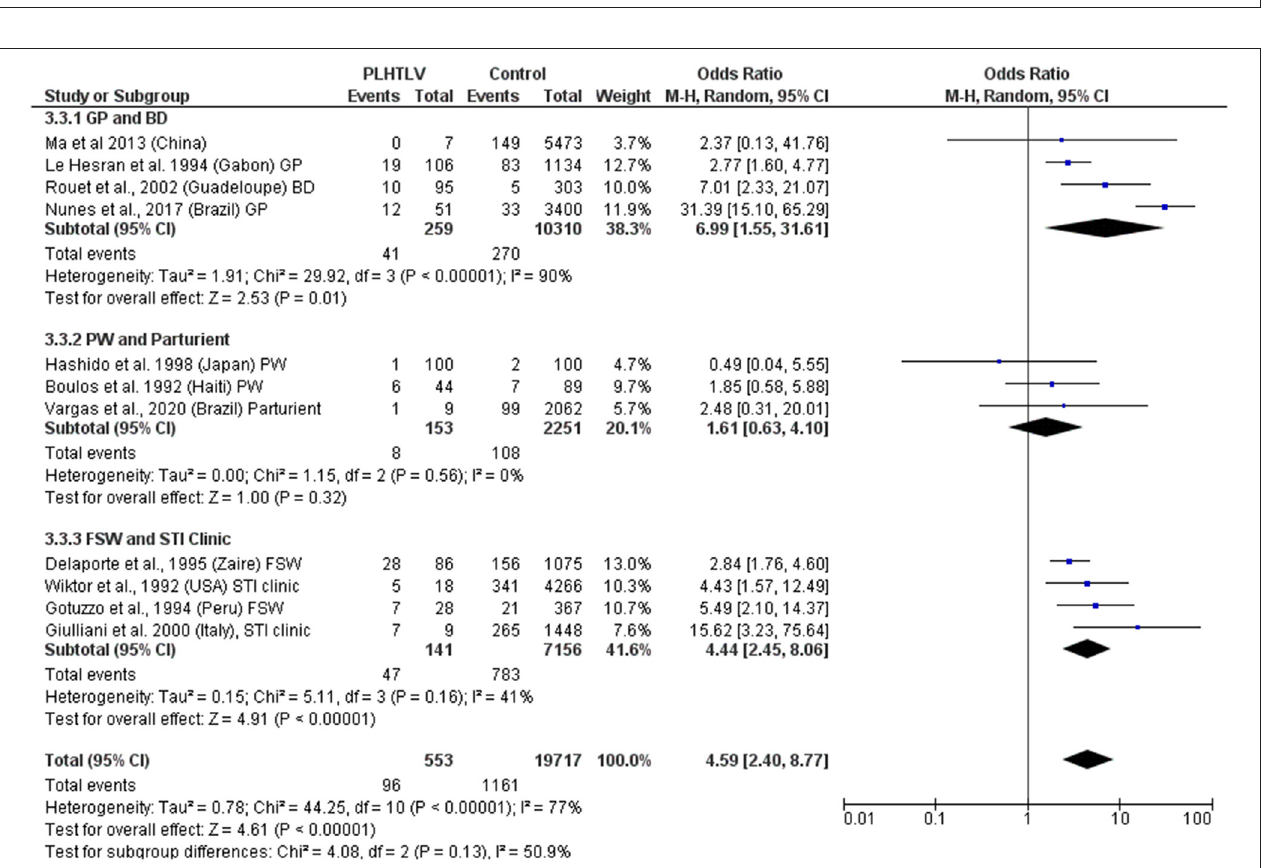
FIGURE 3 | Forest Plot and meta-analysis showing the Odds Ratio of Syphilis infection in people living with HTLV-1. The boxes and lines indicate the odds ratios (ORs) and their confidence intervals (CIs) for each study. The pooled odds ratio is represented by a black diamond. The size of the blue squares indicates the relative weight of each estimate. Statistical analysis and graph were performed using RevMan 5 Software. Odds Ratio was calculated using Random effects model and Mantel-Haenszel statistical method. Measures of heterogeneity between studies in each subgroup (population under investigation) and between subgroups is shown. PLHTLV, people living with HTLV; GP, general population; BD, blood donors; PW, pregnant women; FSW, female sex workers; STI, sexually transmitted infection.